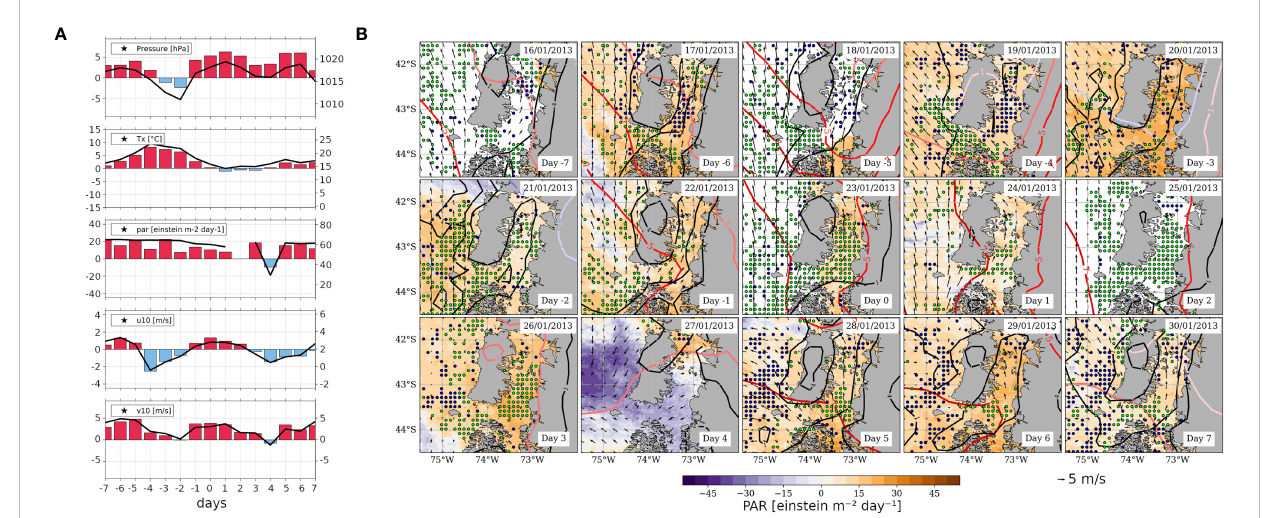
FIGURE 10 As Figure 4, but referred to the case study around the HBE of January 23, 2013 (day 0). (A) Time series calculated as fi eld averages within the S-ISC subregion (42.5°-43.5° S; see Figures 1A) for a sequence of days centred on the HBE onset, i.e., on day 0, spanning from day -7 to day +7. Variables correspond to MSLP [hPa], Tx [°C], PAR [einstein m -2 day -1 ], and U and V components of wind at 10m [m s -1 ]. The right-hand y-axis of each panel shows the absolute values on solid black lines centred around the mean DJF value (central horizontal line), while the left y-axis shows the positive (negative) SY-IS anomalies on red (blue) bars centred around 0. (B) Maps centred on day 0, spanning from day -7 to day +7, showing PAR ’ (shaded, see colour scale), MSLP ’ (reddish contours every 2 hPa), Tx ’ (black contours every 3°C), 10m wind (black vectors, reference vector below the fi gure), and nFLH ’ (green [blue] dots depict gridpoints with nFLH ’ >0.1 [nFLH ’ <-0.1] W m -2 m m -1 sr -1